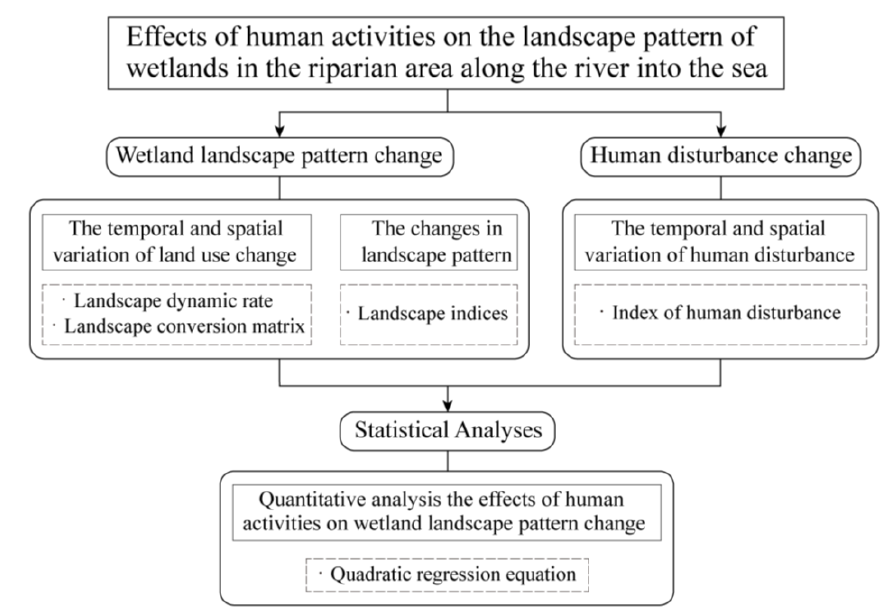
Figure 3. The technology roadmap of the